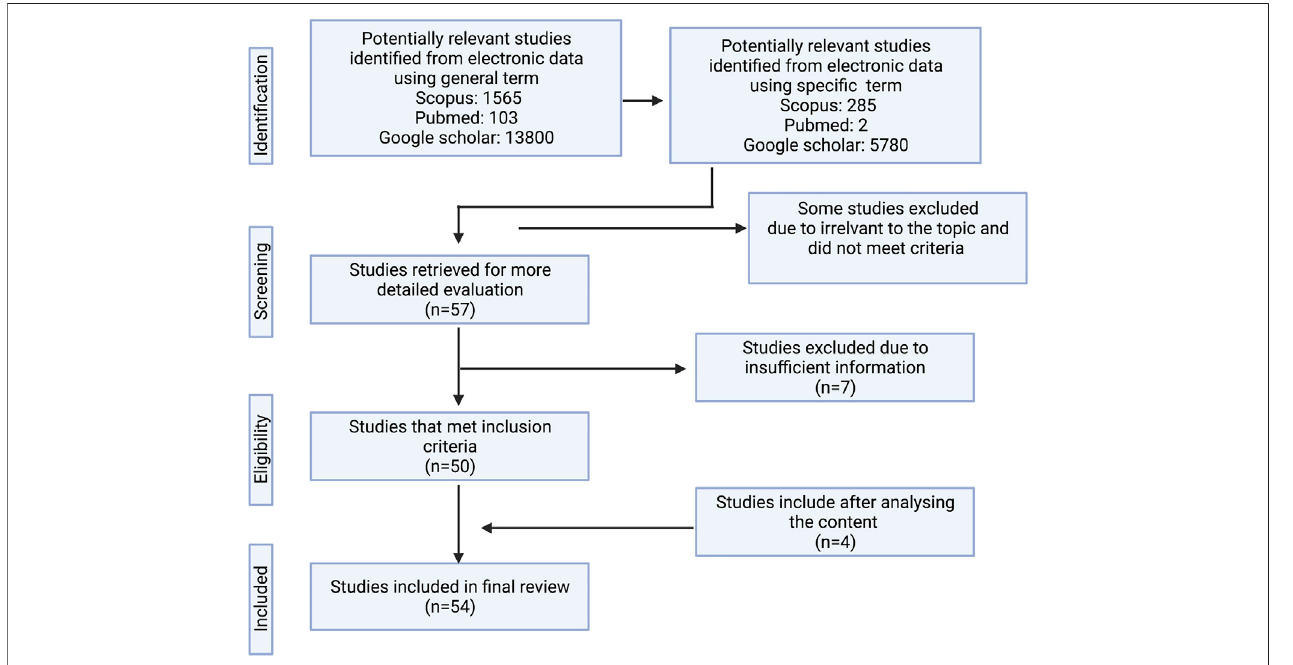
FIGURE 1 | The fl ow diagram of the search